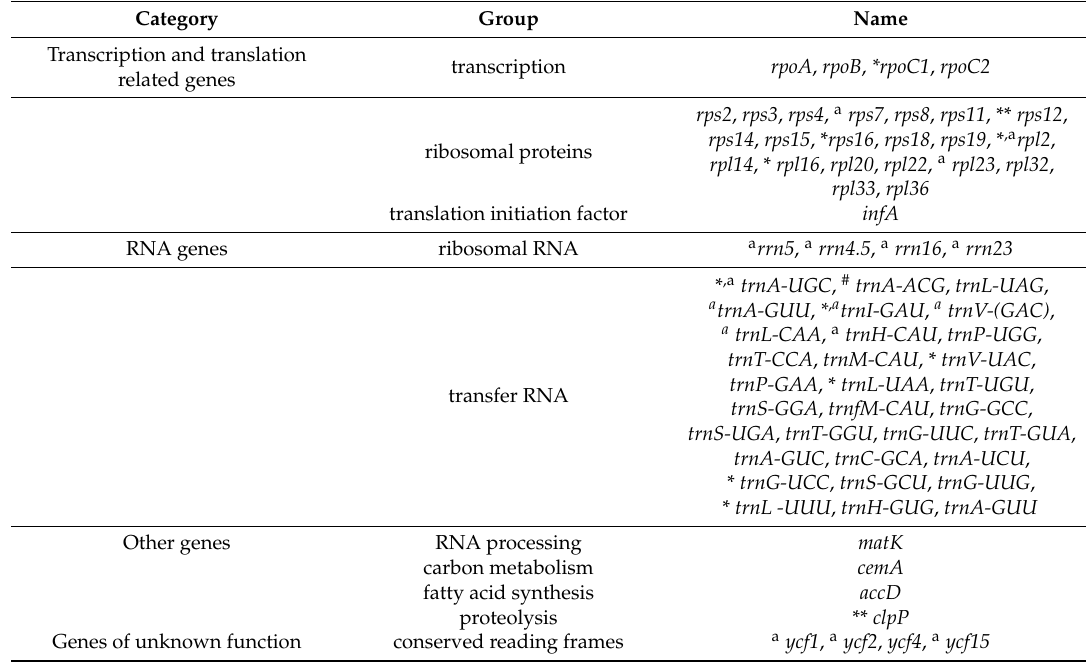
Table 3. Gene list of plastomes of six Rehmannia